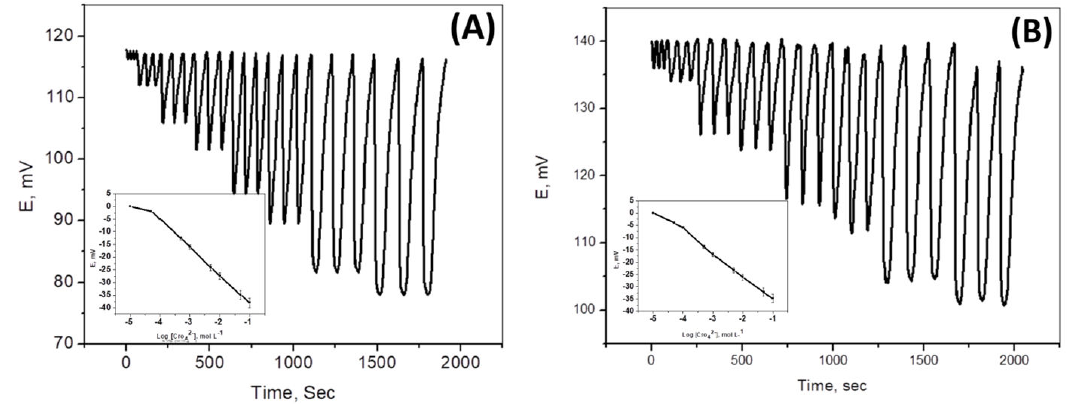
Figure 7. Typical transient flow-injection analysis (FIA) potentiometric signals using: ( A ) Paper based and ( B ) ceramic based chromium(VI) sensors with PANI solid contact; (Conditions: carrier solution, 5.0 × 10 − 3 mol L − 1 Trizma bu ff er of pH ~8, flow rate 4.0 mL min − 1 ; sample volume, 100 µ